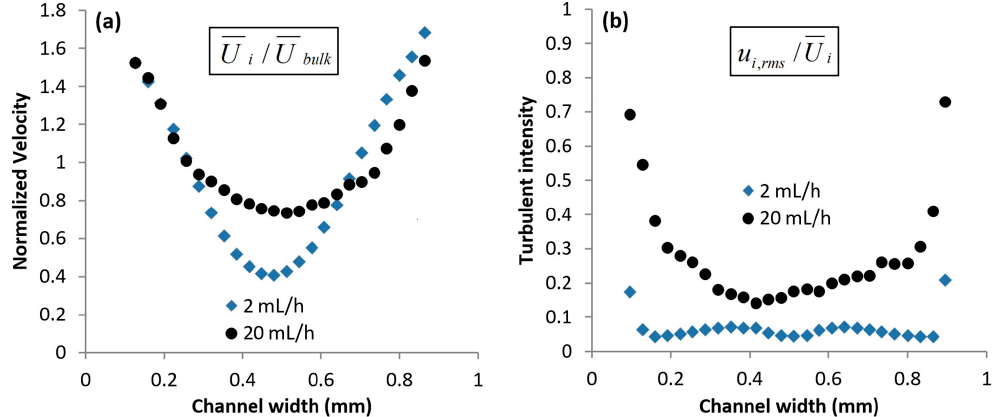
Figure 8. Mean flow statistics at δ = 1.0 mm. ( a ) Normalized axial velocity and ( b ) Turbulent